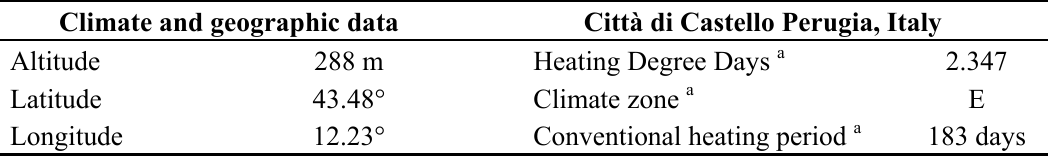
Table 2. Main geographic-related